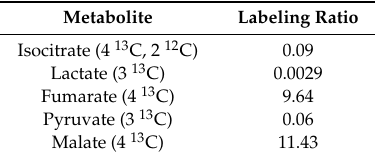
Table 1. Ratios labeled of 13 C-labeled metabolite versus endogenous (all 12 C) metabolite under endogenous baseline conditions using perfusion with Ringer’s solution containing 1 mM 13 C 4 -succinate (all 4 C-atoms 13